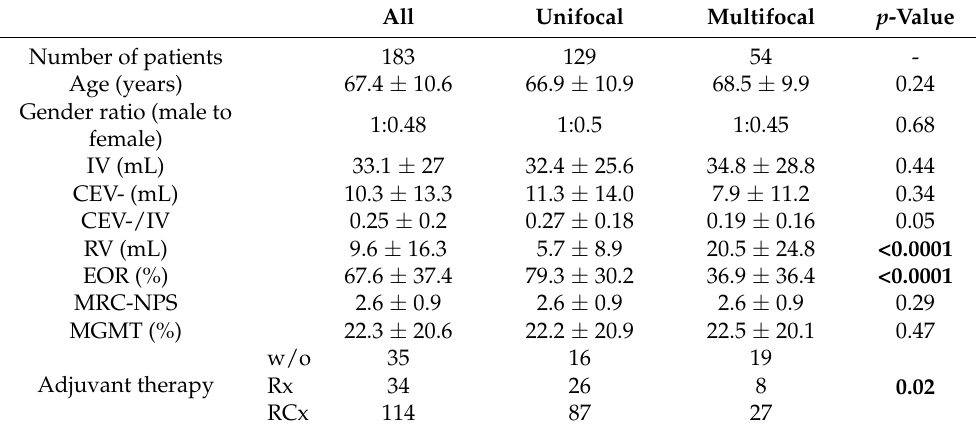
Table 1. Baseline data. Decimal values represent averages with standard